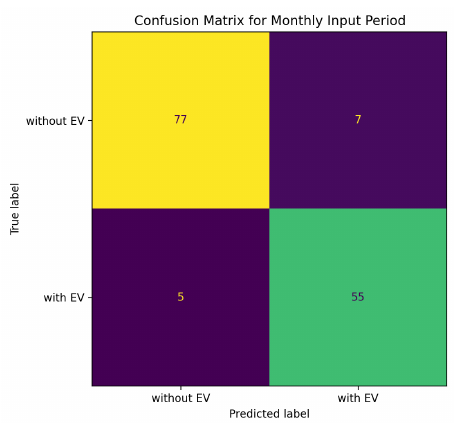
Figure 7. Confusion matrix of the Combined Classifier with the highest classification accuracy in electric vehicle charging detection.